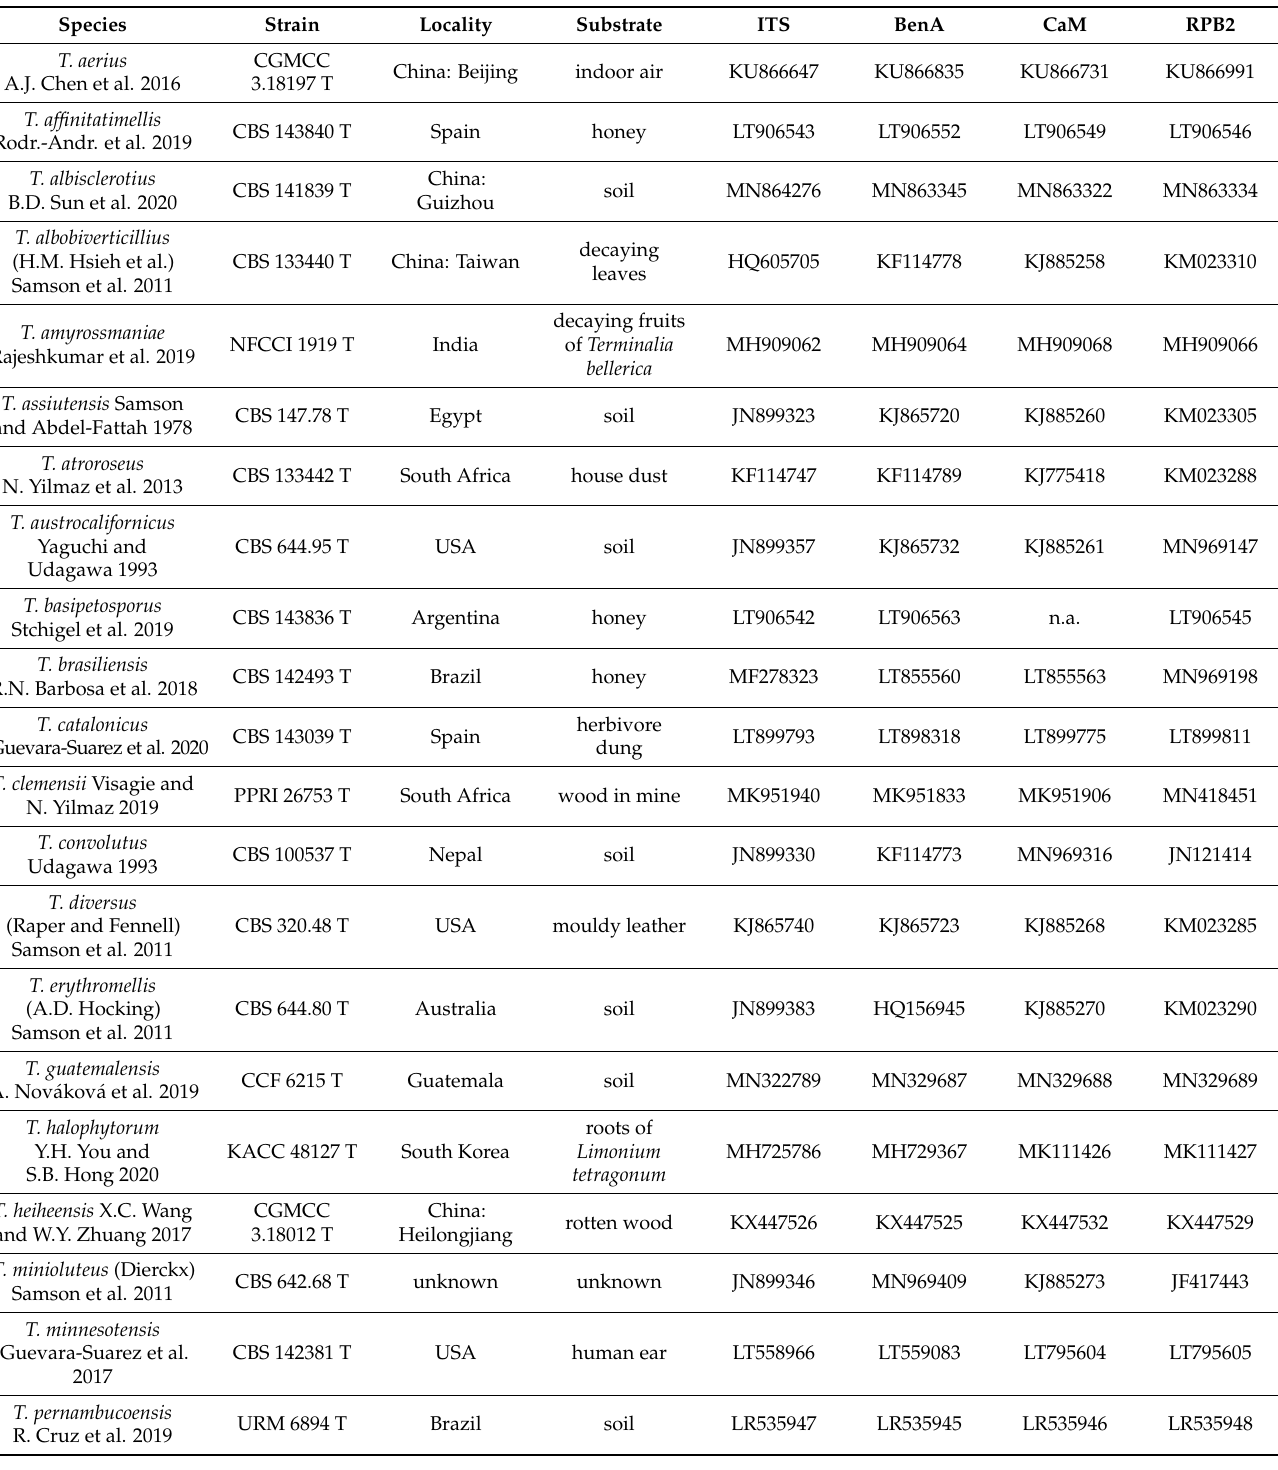
Table 1. Previously described Talaromyces species used in phylogenetic analyses of the sect. Trachyspermi . Species Strain Locality Substrate ITS BenA CaM